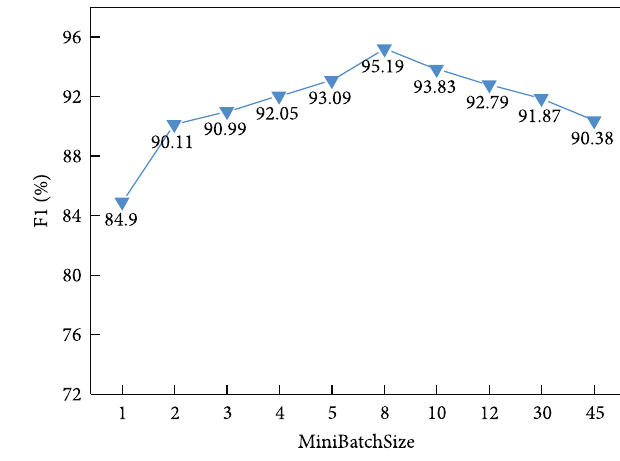
Figure 10: Relationship between MiniBatchSize and F1.